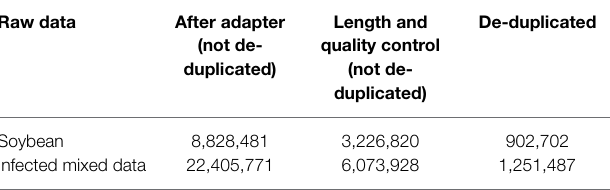
TABLE 1 | Data volume statistics before and after quality